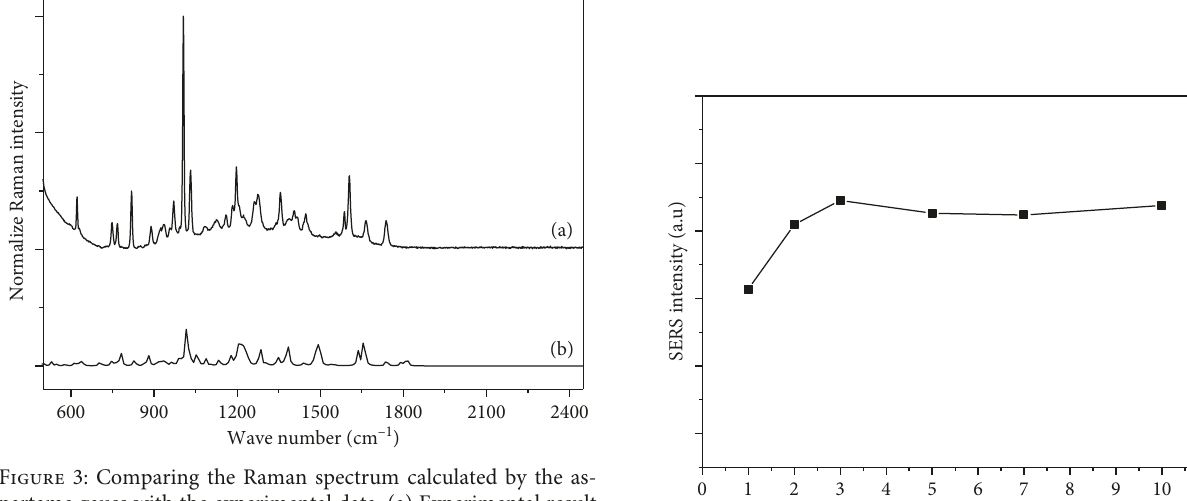
Figure 4: Raman spectra of (a) PDMS plasma cavity, (b) purified water, (c) aspartame saturated solution, (d) aspartame powder, and (e) SERS spectra of aspartame aqueous solution with a concen- tration of 0.3 mg/L.